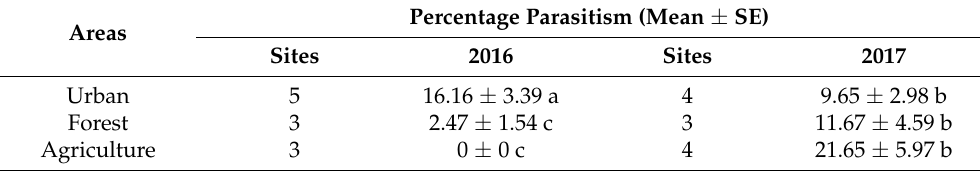
Table 3. Between area comparison of M. cribraria egg parasitized by P saccharalis in 2016 and 2017. Within each column, means followed by common letters are not significantly different (Tukey’s Studentized Range; p < 0.05).